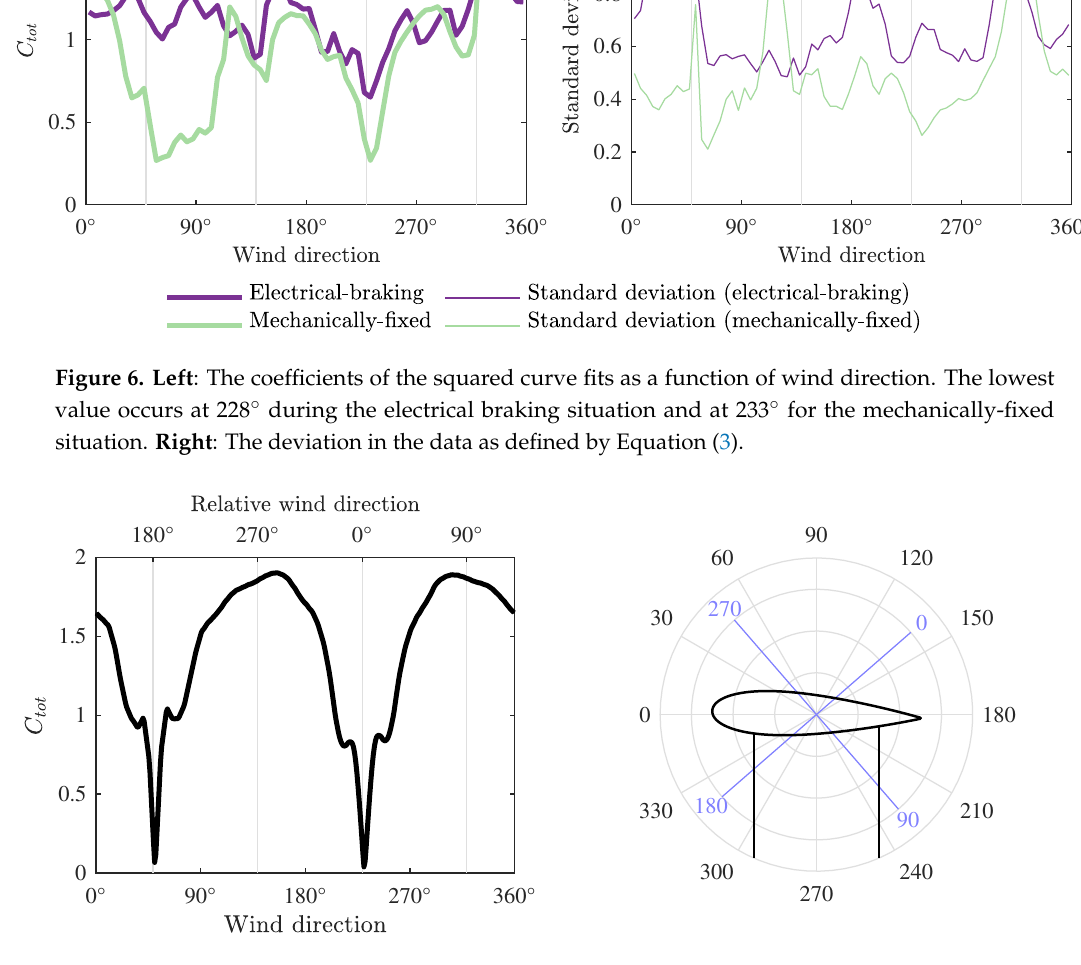
Figure 7. Left : Calculated values for the force coefficient. Right : Illustration of the relative wind direction. The absolute wind direction is illustrated in the blue axis. Note that the blade has a 2 ◦ pitch